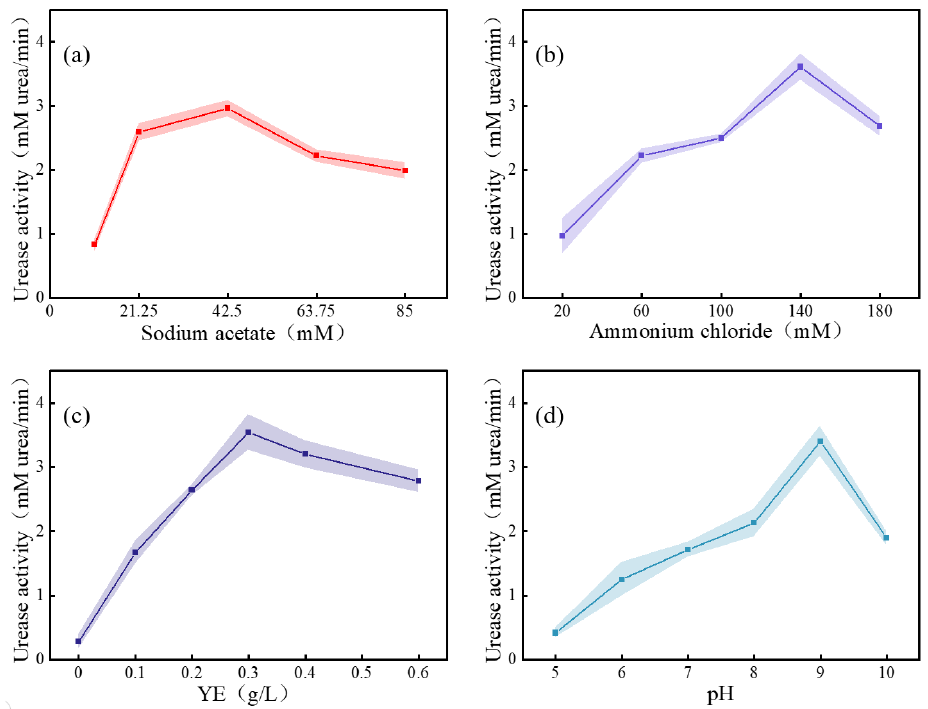
Table 4. Results of PB design.